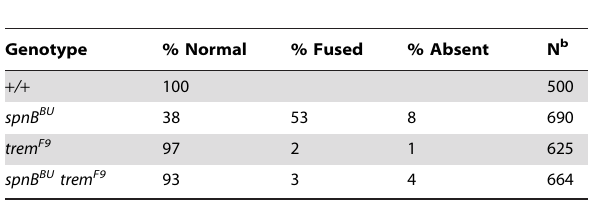
Table 8. Rescue of eggshell defects by trem of the DNA repair mutant spnB a .